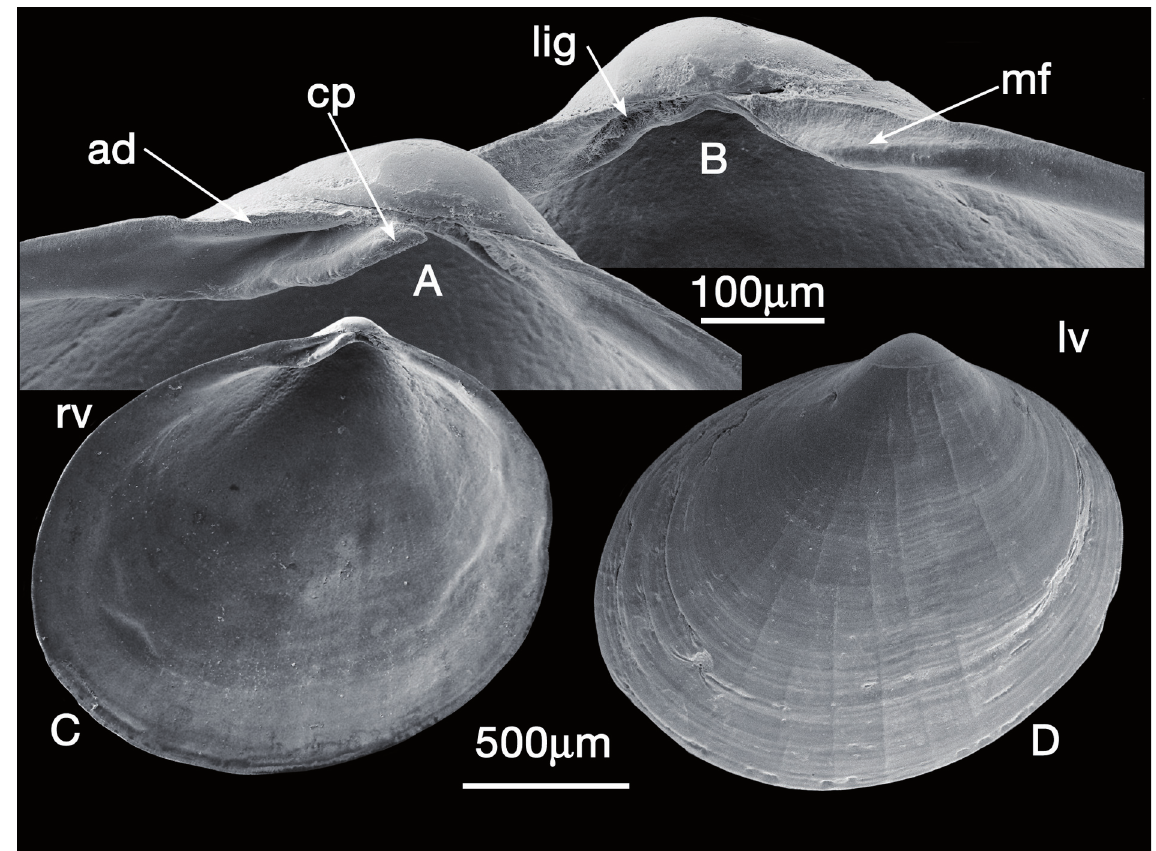
Fig. 6. Montacuta substriata (Montagu, 1808), NMW.Z 2000.101.73. Gulfaks Oil Field, North Sea, 217 m. A-B . SEM of hinges of right and left valves. C. SEM of internal of right valve. D . SEM of external of left